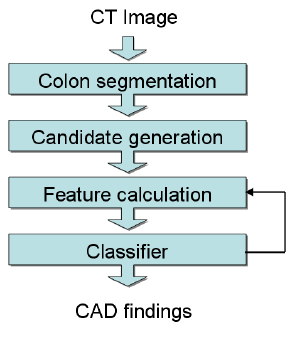
Figure 1. Block diagram for CAD system overview.